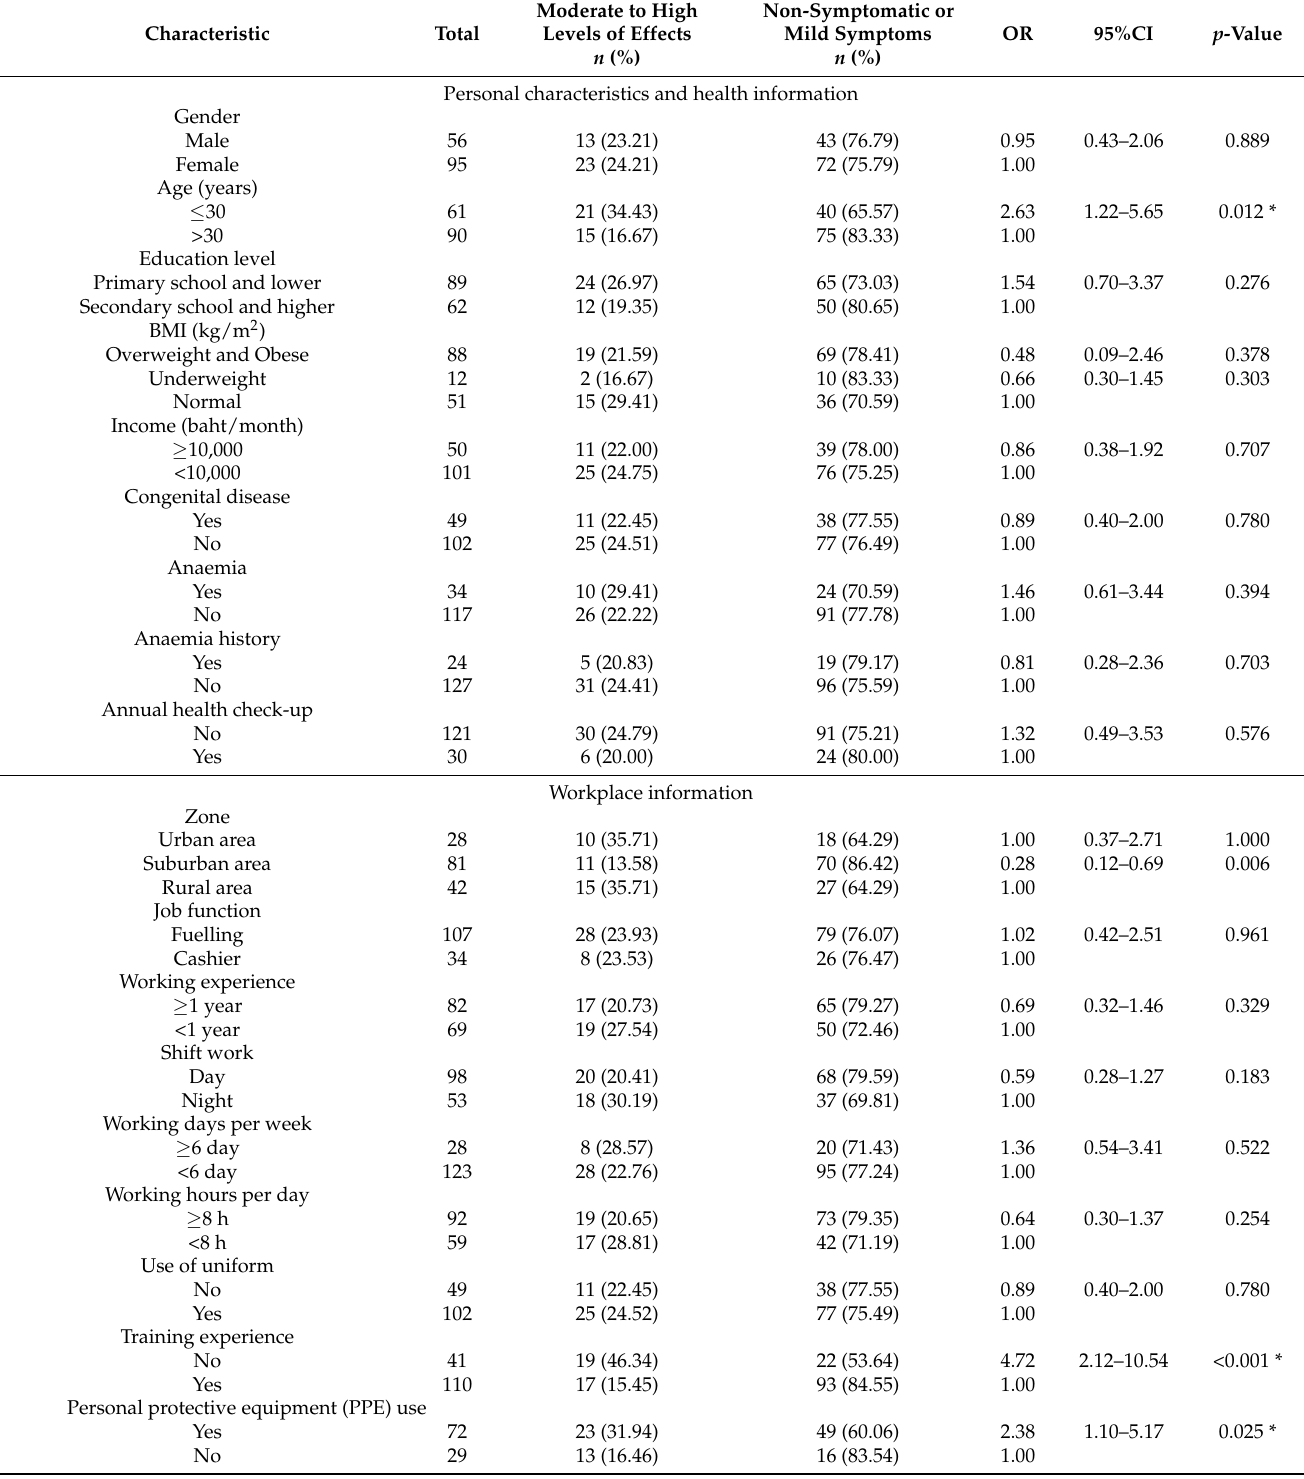
Table 2. Bivariate analysis of the relationship between personal factors and moderate to high levels of adverse effects ( n =